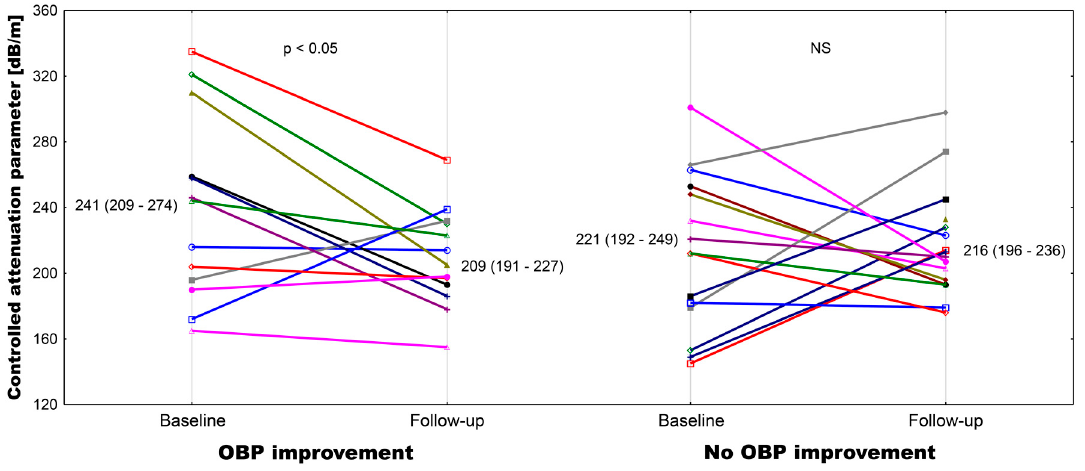
Figure 2. Individual plot of the controlled attenuation parameter at baseline and after the follow-up in patients with and without attended office blood pressure control improvement.